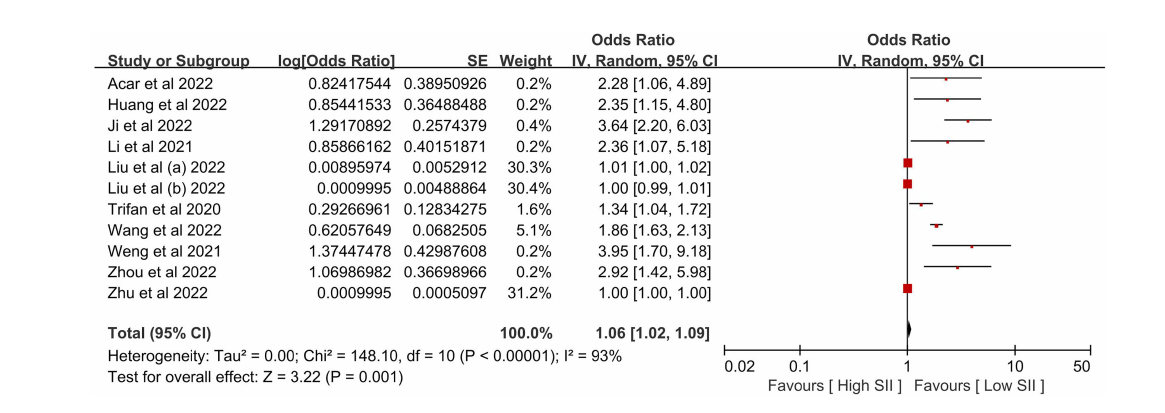
FIGURE 2 The poor outcome between the high SII and low SII groups. Liu et al. (a) and Liu et al. (b) were from the same study, Liu et al. (c) presented minor stroke patients, and Liu et al. (b) presented moderate-to-severe stroke patients. We regarded the two groupings as independent studies when performing a meta-analysis of poor outcomes.